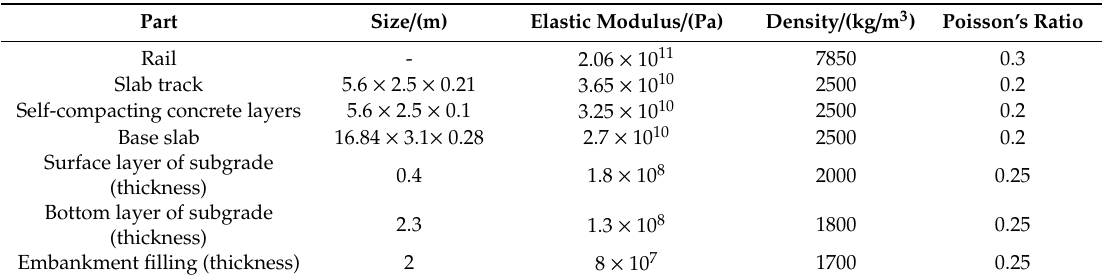
Table 3. Structure parameters of unballasted track.